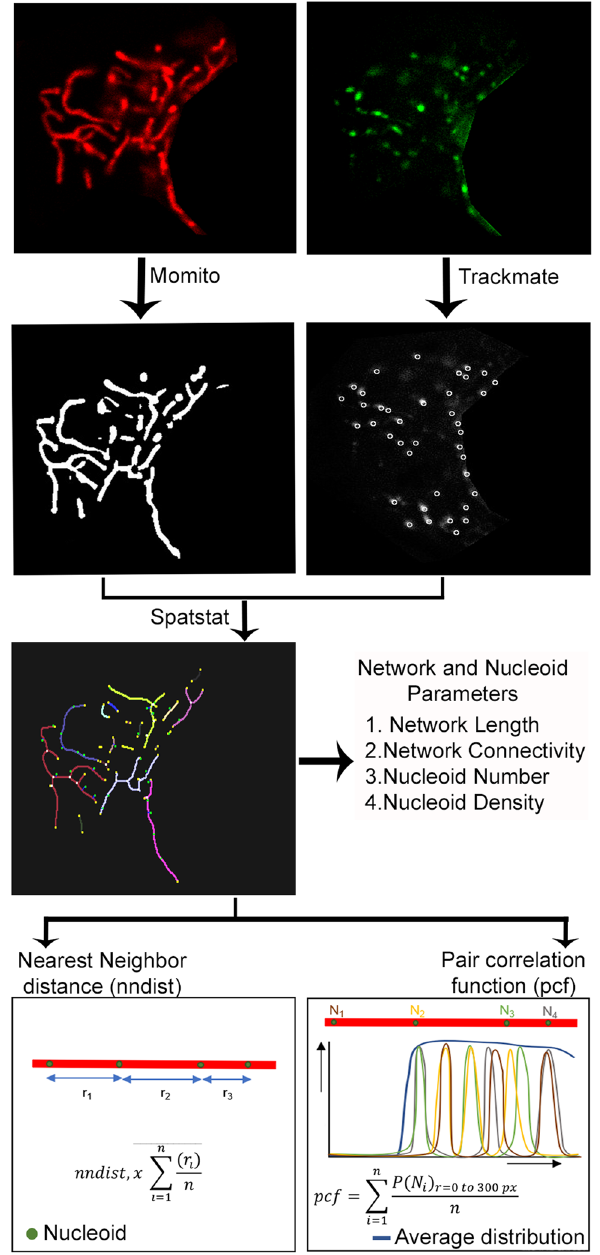
Figure 1. Schematic representation of nucleoid distribution analysis by Mitomate tracker. Confocal live cell Images of mitochondria (TMRM, red) and nucleoids (Picogreen, green—nucleus manually removed) are analyzed using Mitomate tracker. Mitochondria are segmented and their components are identified using Momito while nucleoids are identified using the Image J Plugin Trackmate. The information extracted from Momito and Trackmate is then analyzed by the R package spatstat. Mitomate Tracker provides detailed descriptors of network and nucleoid features and measures nucleoid distribution pattern by two metrics, the nearest neighbor distance (nndist) and the pair correlation function